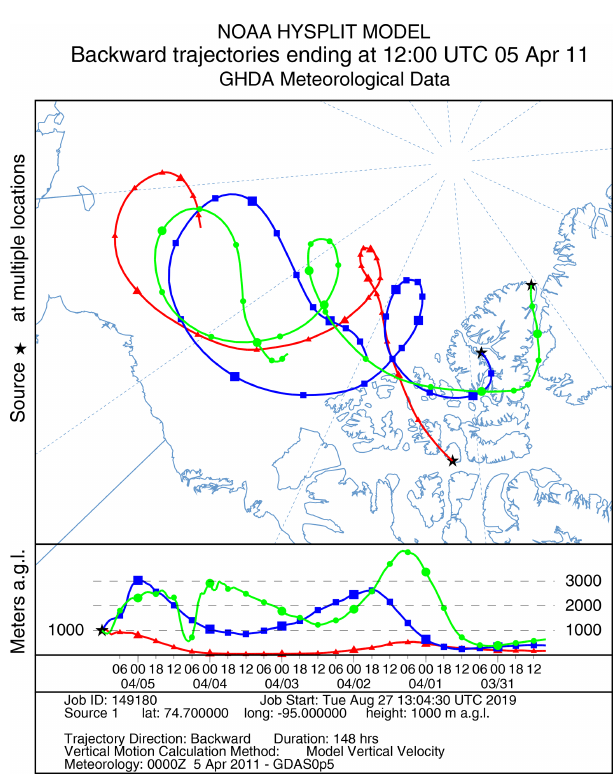
Figure 11. HYSPLIT 6d back trajectories for Resolute, Eureka, and Alert ending at 12:00UTC on 5 April